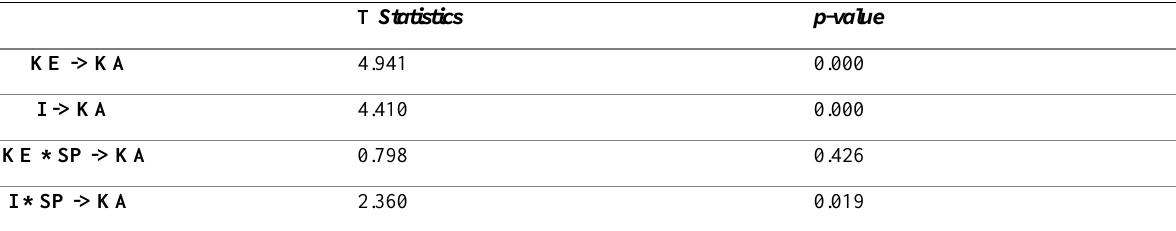
Table 2: Hypothesis Testing